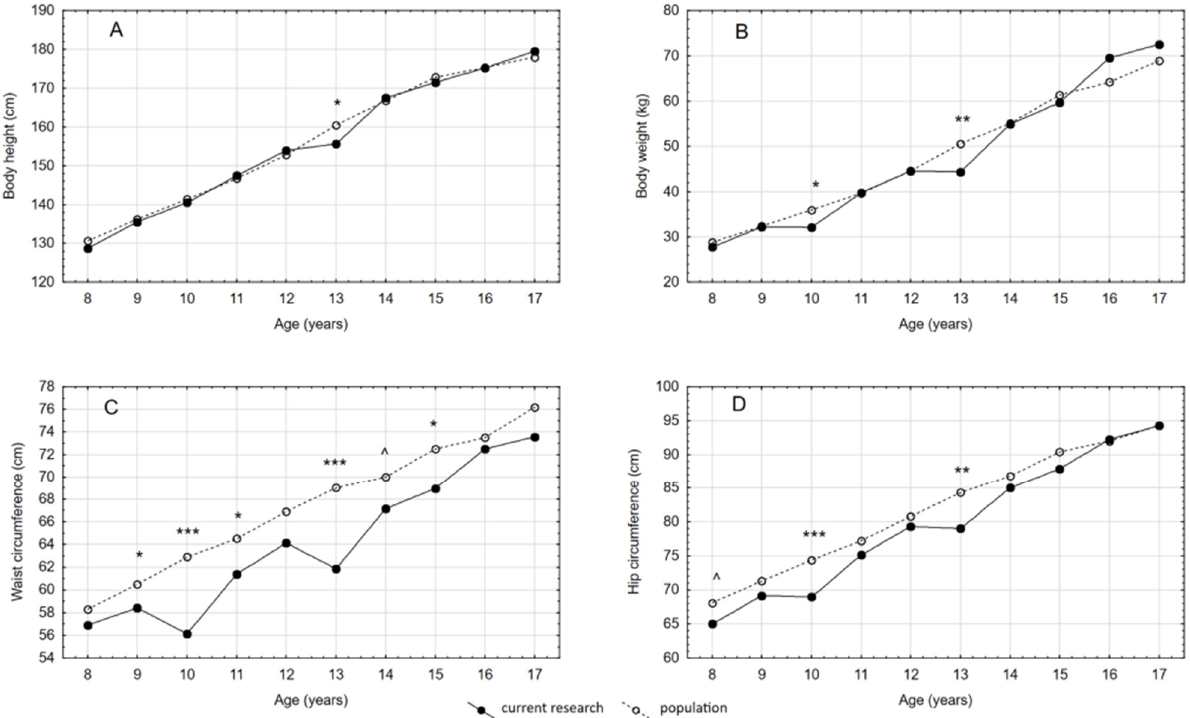
Figure 1. Measurement results of Polish boys aged 8–17 years with type 1 diabetes for ( A ) height, ( B ) weight, ( C ) waist, and ( D ) hip circumference compared with the healthy population norms [18,19]. * p < 0.05, ** p < 0.01, *** p < 0.001—statistically significant; ^ p < 0.1—tendency towards significance; p ≥ 0.05—statistically non-significant.